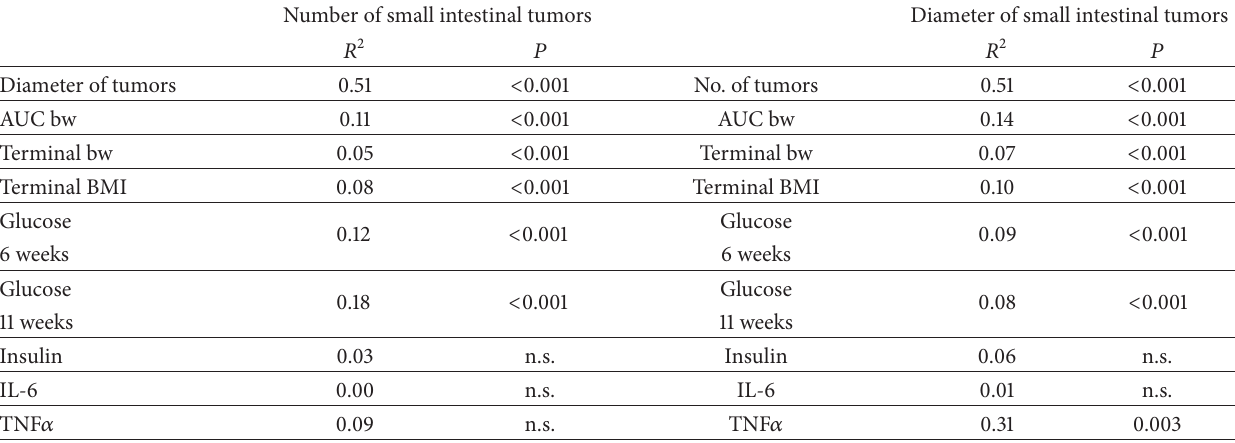
Table 3: Associations between body weight, glucose, insulin and cytokine levels and the number or diameter of small intestinal tumors. Number of small intestinal tumors Diameter of small intestinal